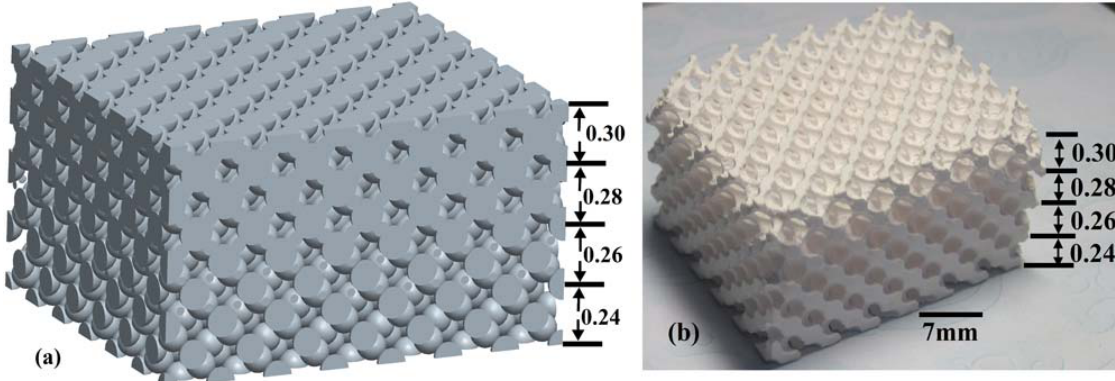
Figure 1. ( a ) The resin mold and the fabricated sample; ( b ) of diamond-structured photonic crystal (PC) with graded air spheres